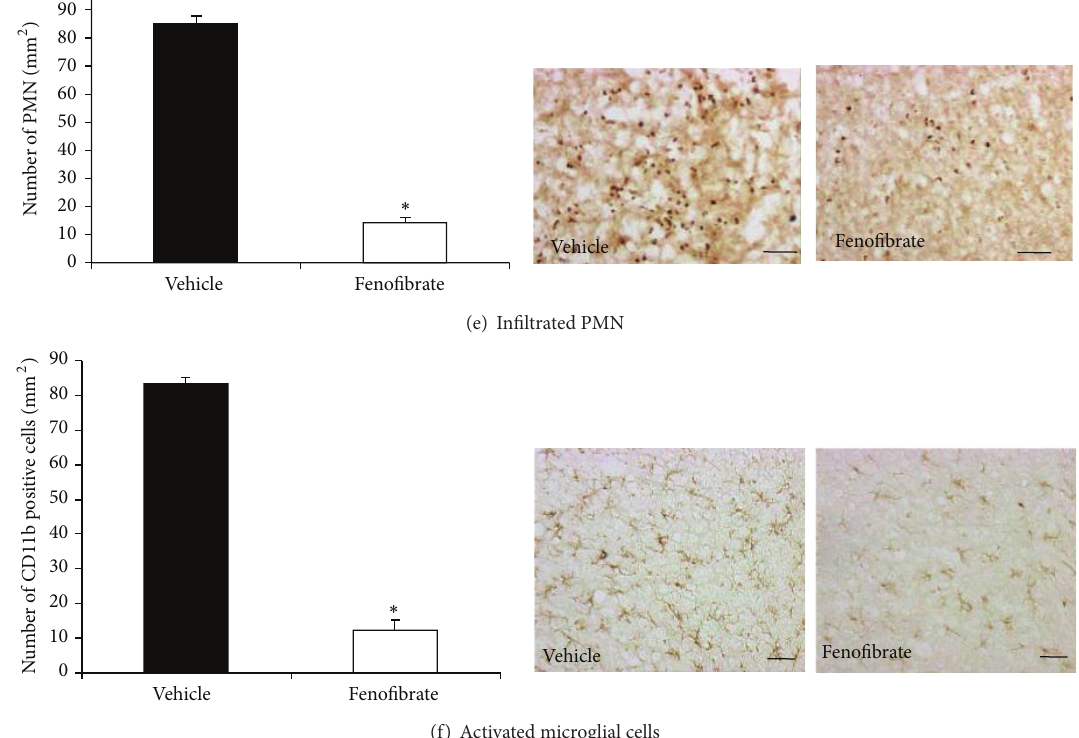
Figure1:EvaluationoftheeffectsofthePPAR- 𝛼 agonistfenofibrateadministeredduringtheacutephaseofexperimentalstokeincombination with thrombolysis with tPA on neuronal and vascular compartments. Evaluation takes place 72 h after the induction of middle cerebral artery occlusion in the rat. Fenofibrate (50 mg/kg/day) or vehicle was administered by twice-daily gavage over 72 h. Values are means ± SEM. (a) Blinded, histological evaluation of the number of petechiae (as seen in the picture) in the infarct area revealed a significant decrease ( ∗ 𝑝 < 0.05 ) in the hemorrhagic risk of tPA when fenofibrate had been administered ( 𝑛 = 7 –9 per group). (b) The total, cortical, and striatal infarction volumes were clearly lower in fenofibrate-treated rats, compared with the vehicle group ( 𝑛 = 7 –9 per group, ∗ 𝑝 < 0.05 ) as seen in the histological images for cresyl fast violet staining. (c) The application of increasing doses of acetylcholine led to endothelium- dependent relaxation, which was altered by ischemia and thrombolysis ( ∗ 𝑝 < 0.05 ). However, the postischemia dysfunction in relaxation was prevented by acute treatment with fenofibrate ( # 𝑝 < 0.05 ) ( 𝑛 = 5 -6 per group). (d) Expression of ICAM-1 adhesion protein, a marker of leukocyte/endothelium interactions, was increased during ischemia and thrombolysis but was lowered by fenofibrate treatment ( 𝑛 = 5 per group; ∗ 𝑝 < 0.05 ); scale bar, 100 𝜇 m. (e) Neutrophil infiltration into the infarct area, quantified by counting the anti-myeloperoxidase-positive cells, was significantly decreased by fenofibrate treatment ( 𝑛 = 5 per group; ∗ 𝑝 < 0.05 ). Scale bar, 100 𝜇 m. (f) Expression of CD11b by Ox 42 antibody, a marker of microglial activation, was increased during ischemia and thrombolysis but was lowered by fenofibrate treatment ( 𝑛 = 5 per group; ∗ 𝑝 < 0.05 ); scale bar, 25 𝜇